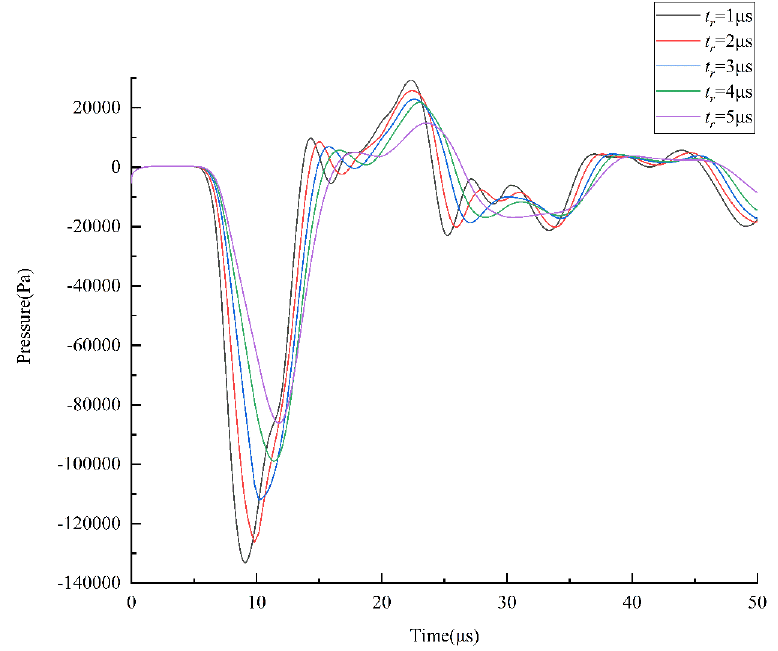
Figure 5. Effect of t r on the pressure at the nozzle.